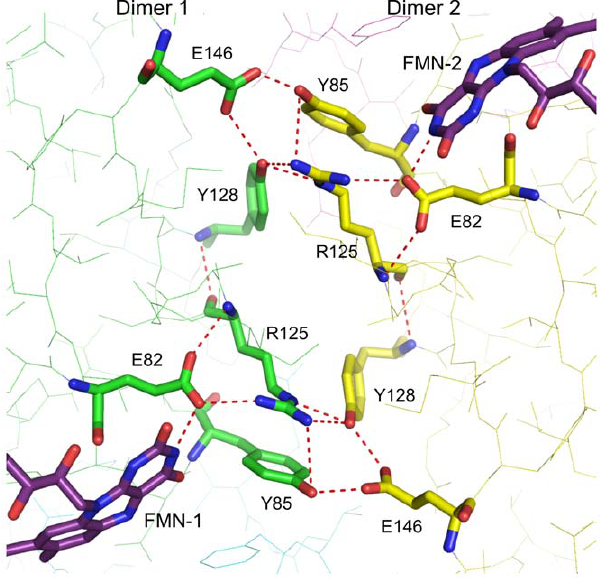
Figure 3. Hydrogen bonding network between FMN molecules from two different dimers of ChrR. Residue Tyr128 is closer to the FMN belonging to the symmetry-related dimer (8.4 A˚) than to the FMN of the original molecule (14.1 A˚). Abbreviations: E=Glu; R=Arg; Y=Tyr.